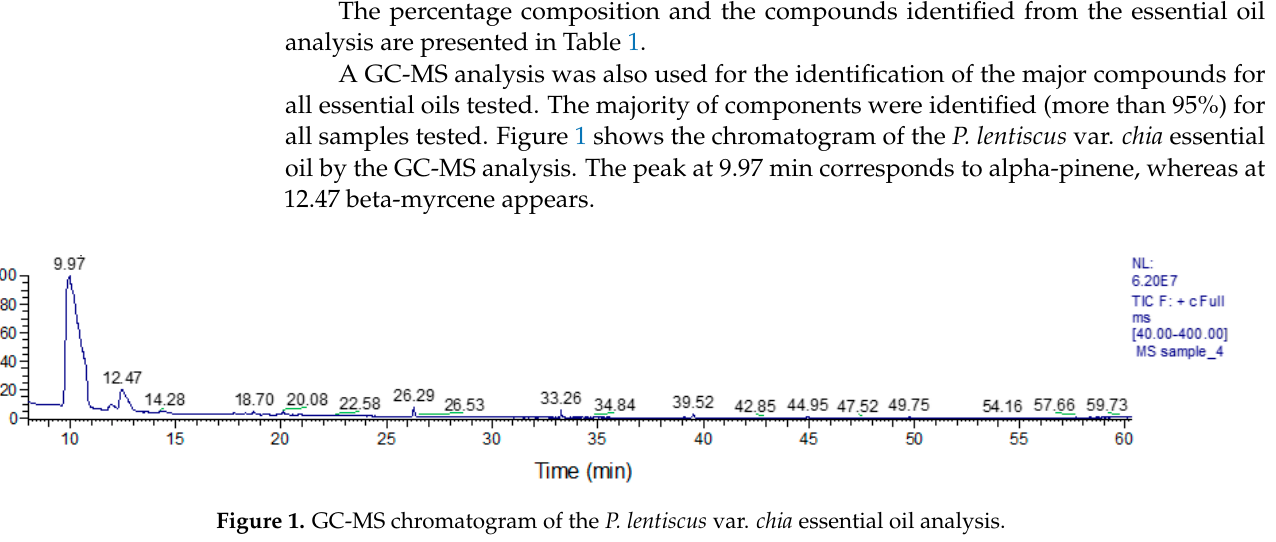
Figure 1. GC-MS chromatogram of the P. lentiscus var. chia essential oil analysis.